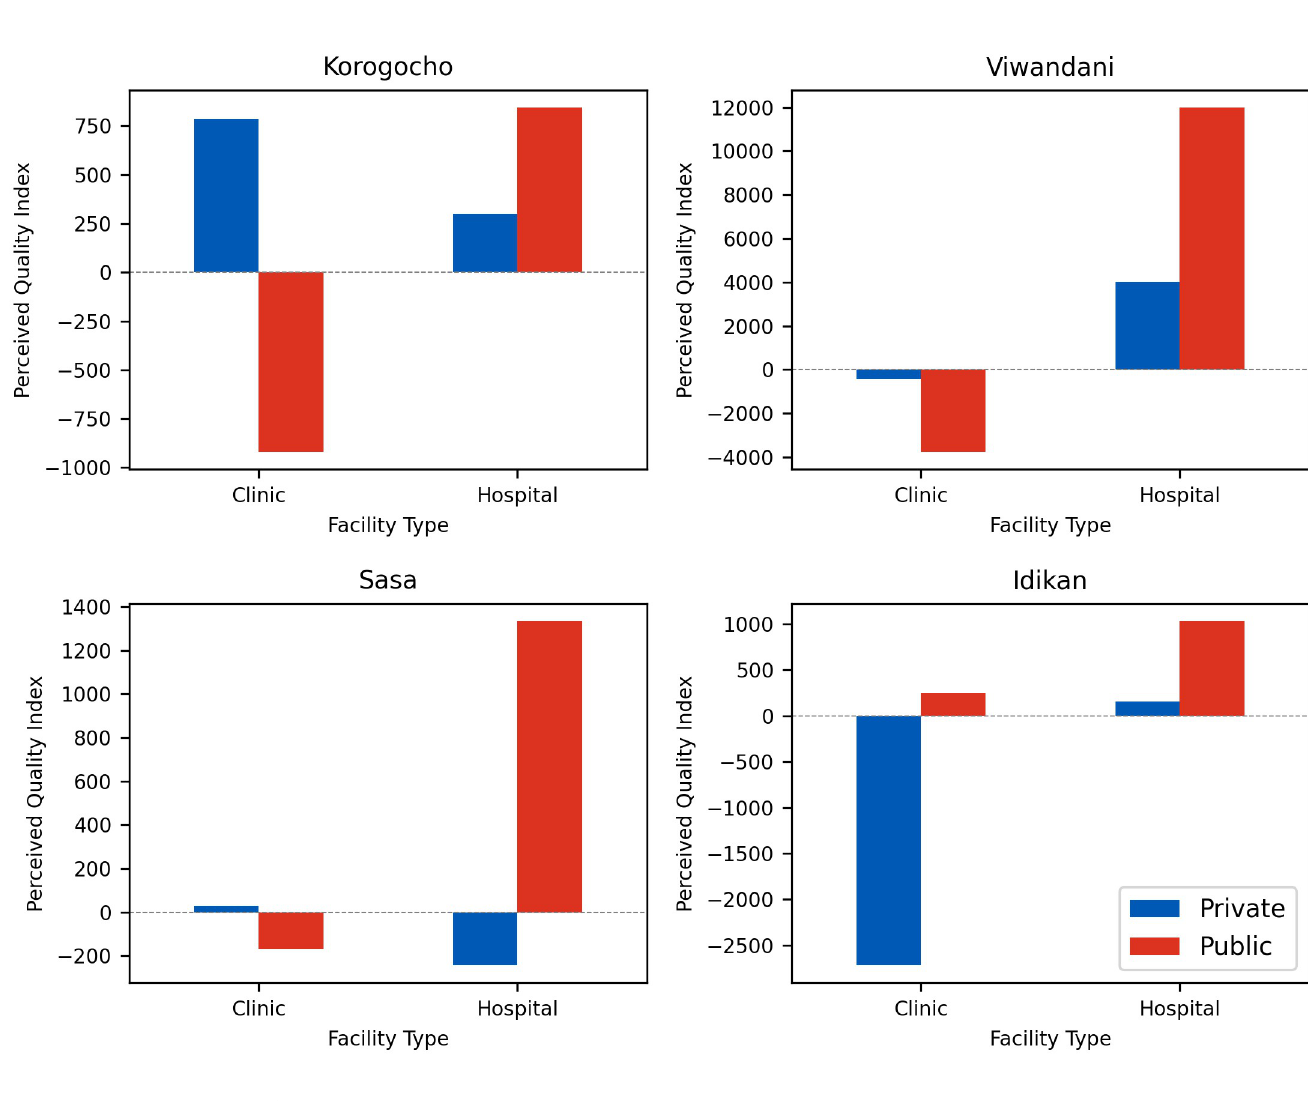
Fig 7. Mean HCP attractiveness index